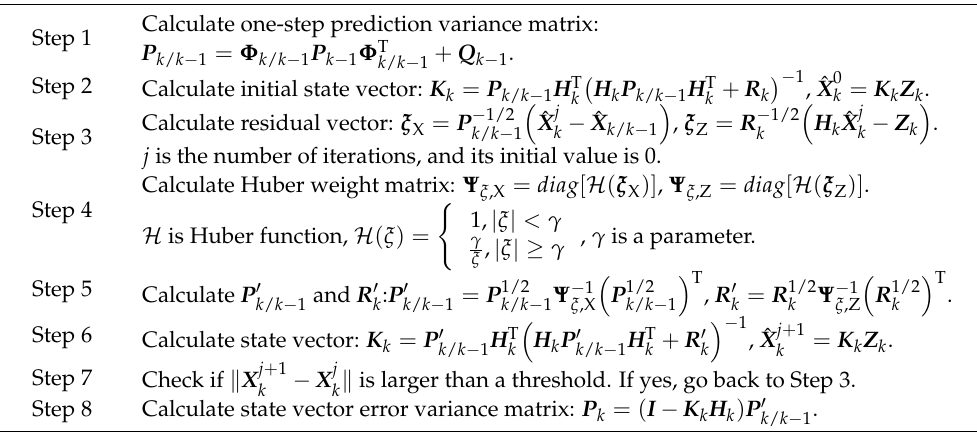
Algorithm 1. Huber-based Kalman filter for the navigation